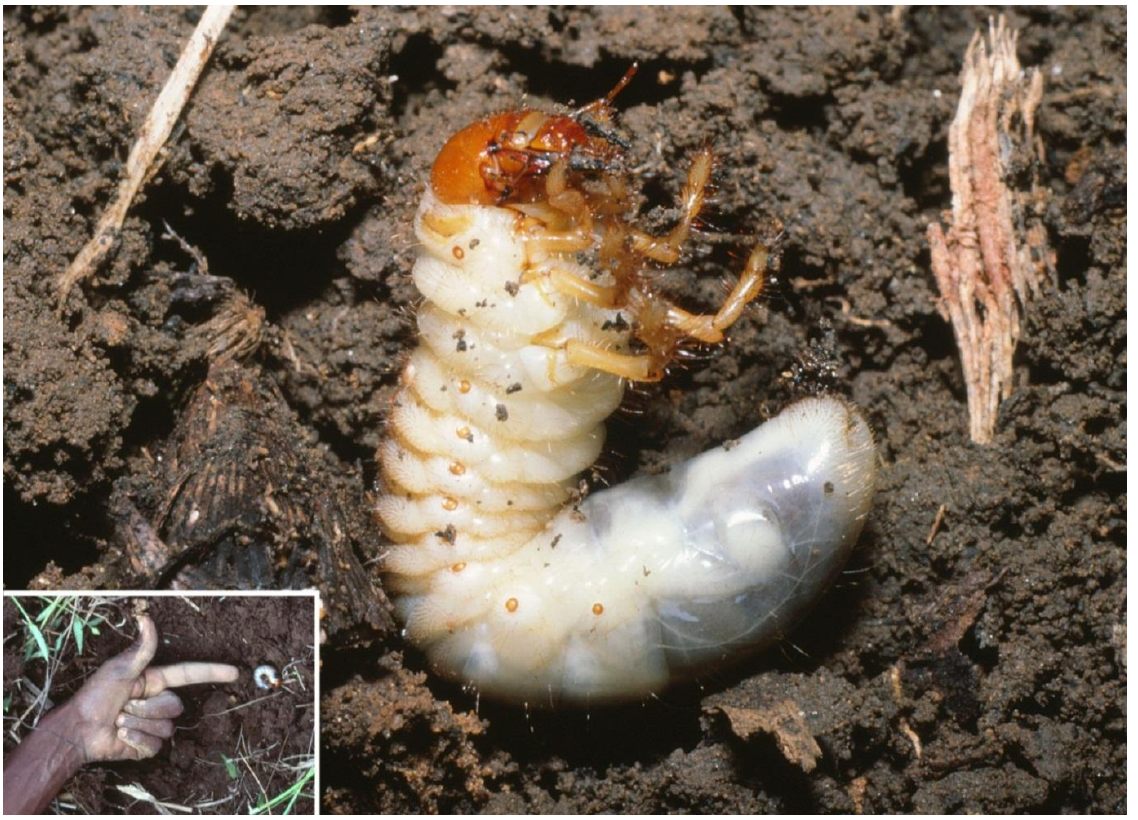
Figure 2. Third instar larva of Cochliotis melolonthoides , Juba Sugar Project, Somalia, October 1986.